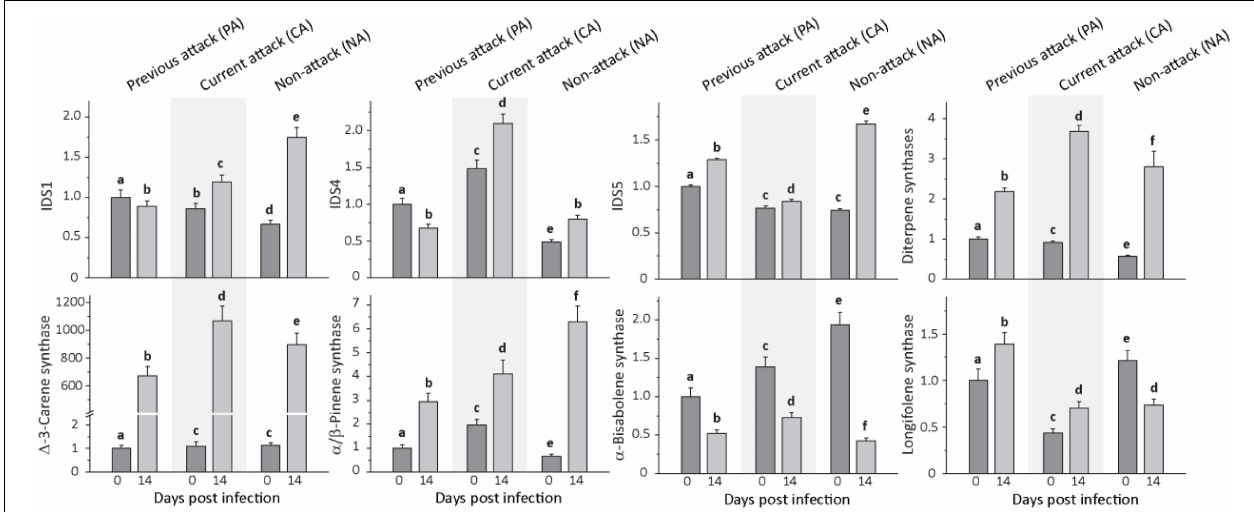
FIGURE 4 | Relative expression of terpene biosynthetic genes before and after Endoconidiophora polonica infection. The expression of isoprenyl diphosphate synthase 1 (IDS1), IDS 4, IDS5, and various terpene synthases (diterpene synthases, δ -3-carene synthase, α / β -pinene synthase, α -bisabolene synthase, and longifolene synthase) were measured by quantitative real-time PCR analysis from bark tissue harvested before and 14 days after infection with E. polonica . Trees investigated: (1) were from a stand with a history of previous bark beetle attack, but no current attack (PA), (2) were under current attack, but had no previous history of attack (CA), or (3) had no previous nor current attack (NA). Different letters indicate significant differences. Data are means ± SD of measurements from 6 to 12 biological replicates; exact numbers are given in the Section “Materials and Methods.” Statistical values for individual compounds are given in Supplementary Table 6 .